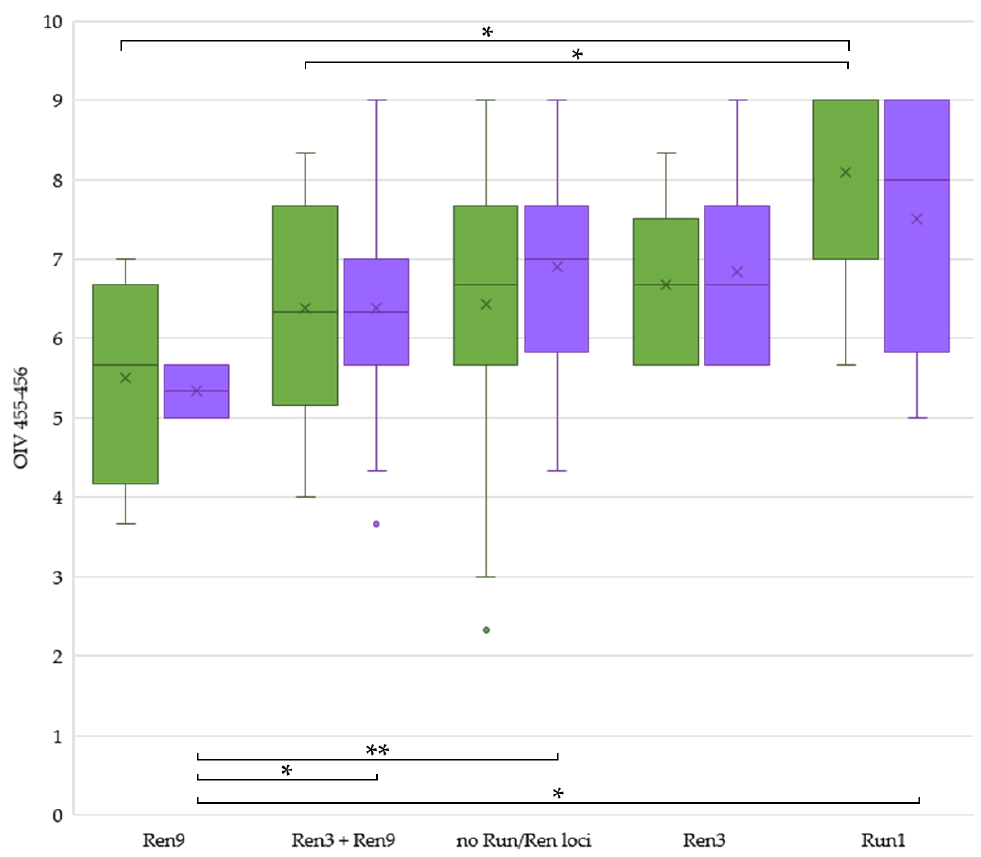
Figure 4. Evaluation of field resistance to downy ( A ) and powdery ( B ) mildew on leaves (green) and bunches (violet) on clustered accessions according to the presence of resistance ( R ) loci. Per each accession, OIV scores were averaged by 3-years. Per each year, the lowest score between evaluations was chosen. Box plots show medians by middle line and means by x. *: p < 0.05; **: p < 0.01.